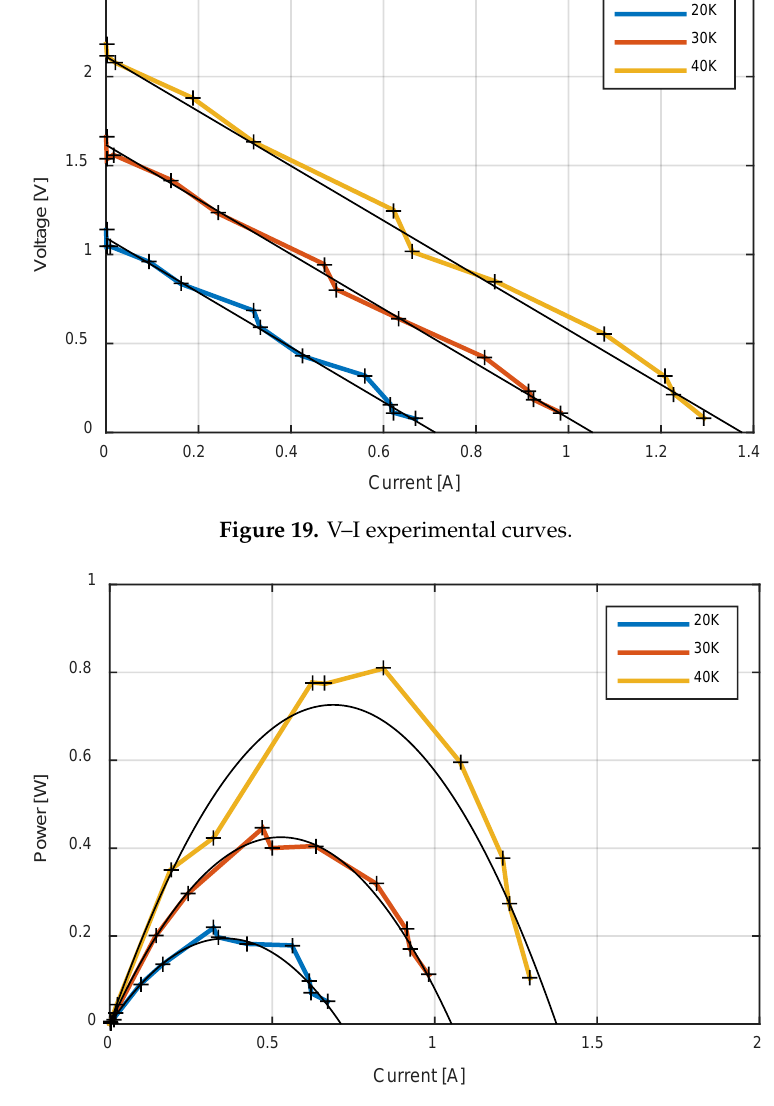
Figure 20. P–I experimental curves.